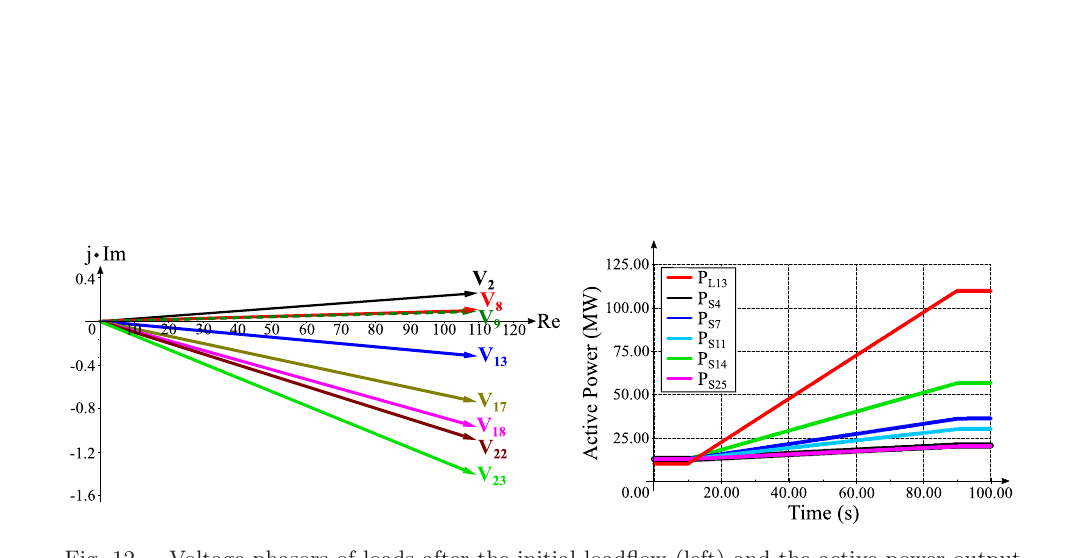
Fig. 12. – Voltage phasors of loads after the initial loadflow (left) and the active power output of the storage power plants along with the change in load power consumption (right).